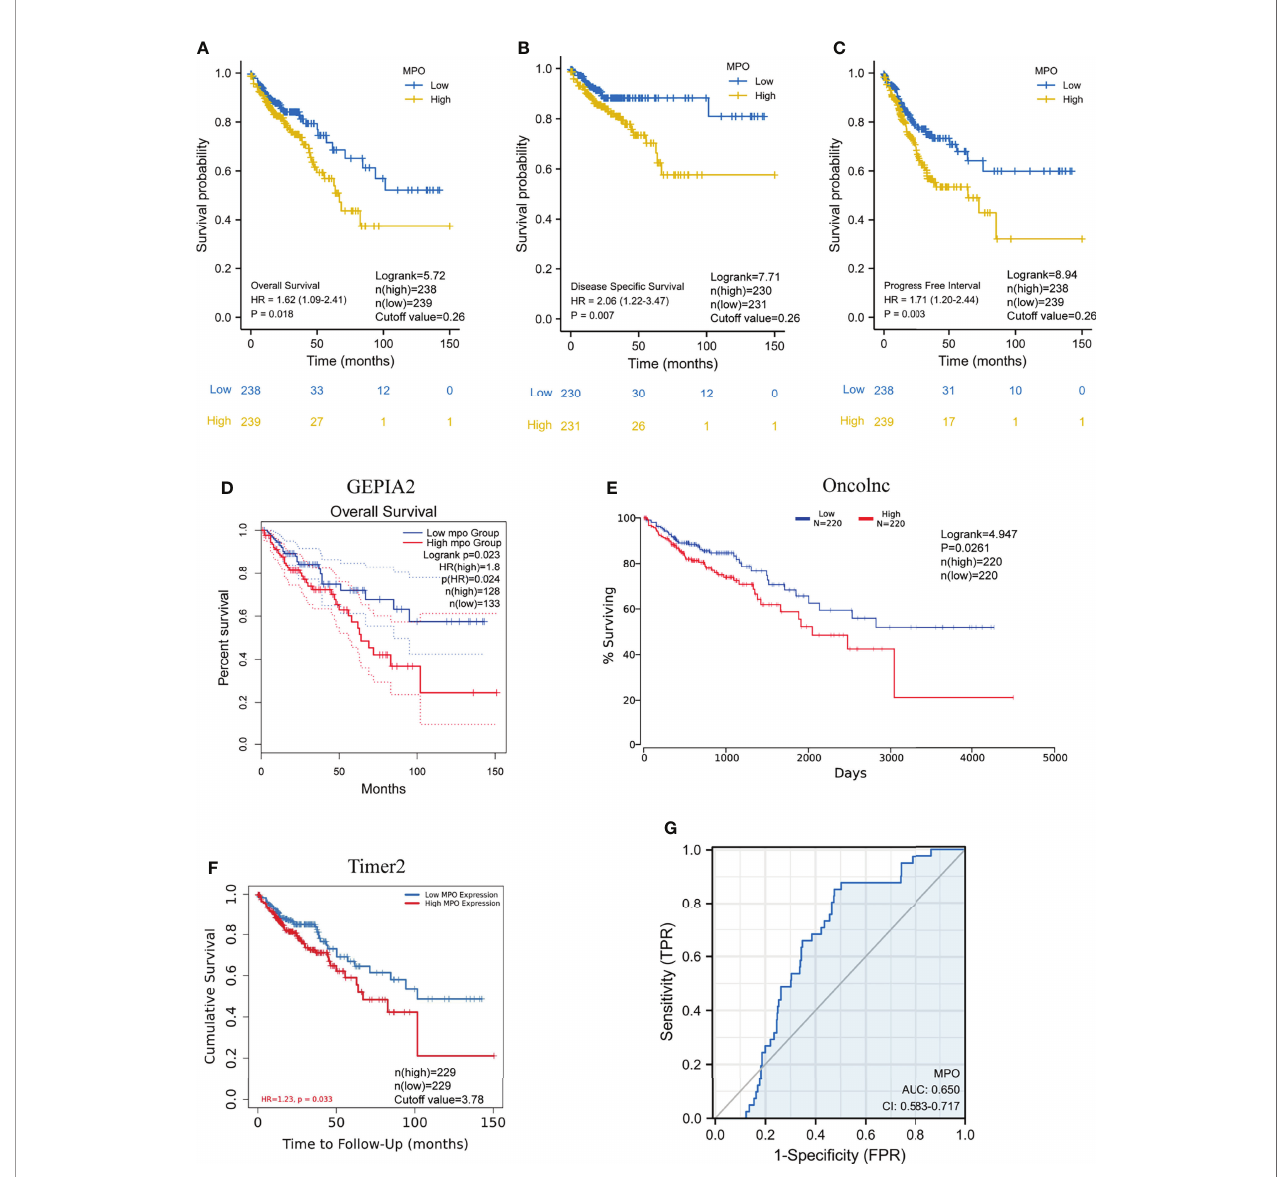
FIGURE 2 | High expression of MPO is related to poor prognosis in CRC patients. (A – C) Kaplan – Meier analyses of OS, PFI, and DSS between the low- and high- MPO groups in TCGA. OS: Logrank=5.72, P=0.018, n(high)=238, n(low)=239, cutoff value=0.26; DSS: Logrank=7.71, P=0.007, n(high)=230, n(low)=231, cutoff value=0.26; PFI: Logrank=8.94, P=0.003, n(high)=238, n(low)=239, cutoff value=0.26. (D – F) Gene Expression Pro fi ling Interactive Analysis2 (GEPIA2), OncoLnc, and TIMER2 databases were used to analyze overall survival between high and low MPO groups, respectively. GEPIA2 OS: P=0.023, n(high)=128, n(low)=133; OncoLnc OS: Logrank=4.947, P=0.0261, n(high)=220, n(low)=220, cutoff value=3.78; TIMER2 OS: P=0.033, n(high)=229, n(low)=229. (G) ROC analysis with respect to the MPO